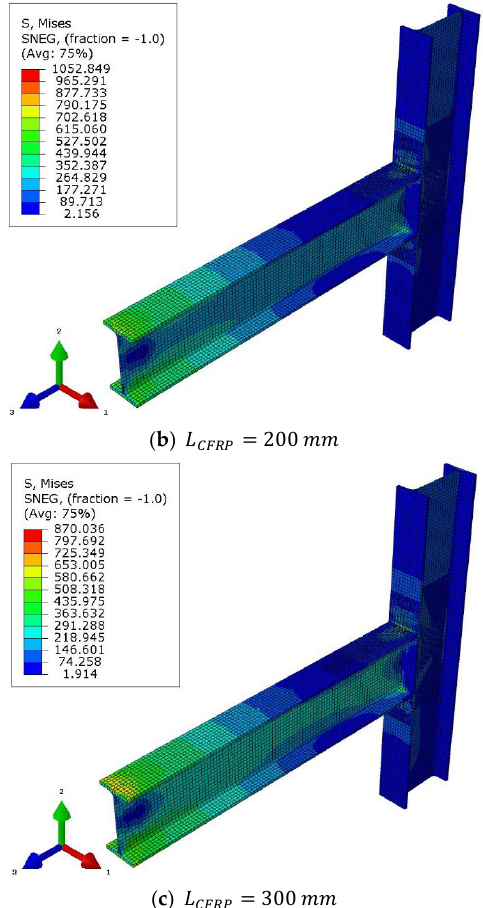
. Figure 14. Contour plot of the von Mises stress as a function of the strengthening length L CFRP . 𝐿𝐿 𝐶𝐶𝐶𝐶𝐶𝐶𝐶𝐶